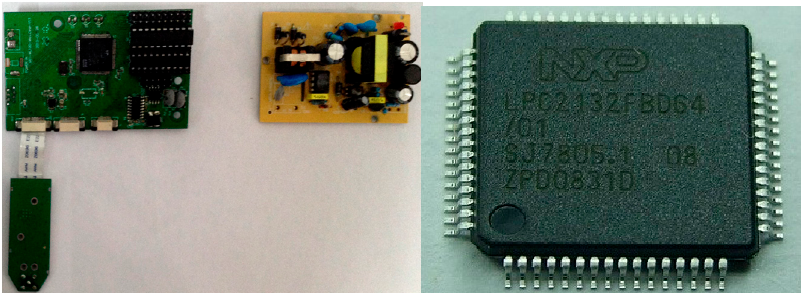
Figure 8. Signal Reader.